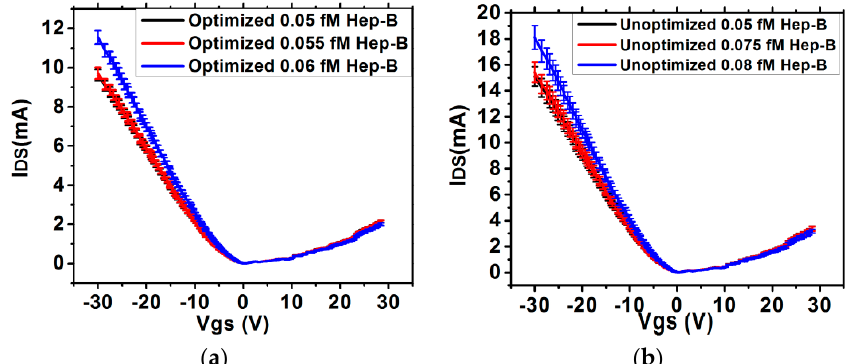
Figure 9. I DS - V GS characteristics for low concentration of Hep-B in ( a ) optimized and ( b ) un-optimized (24 h treated) sensor.